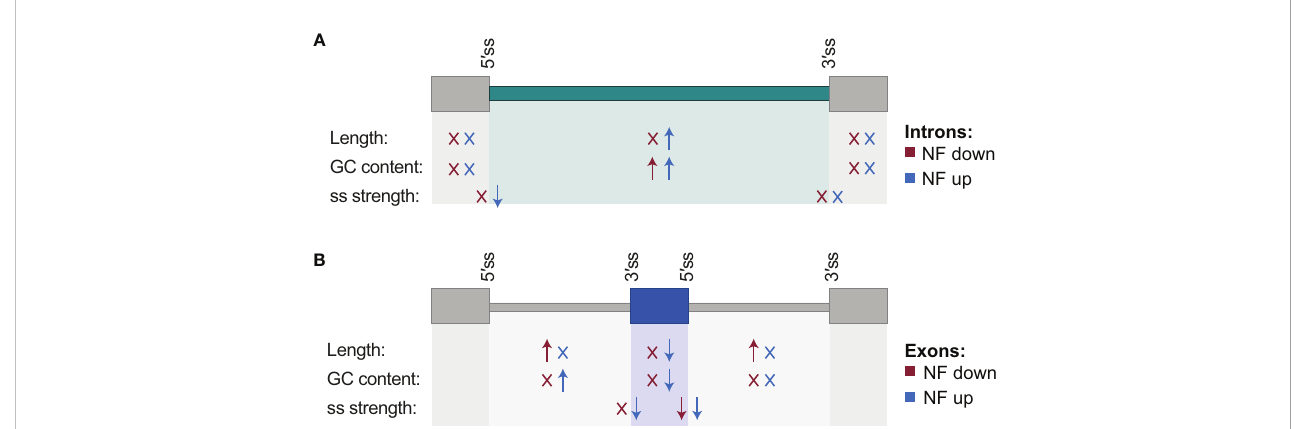
FIGURE 3 Schematic representation of genomic regulatory features associated with differentially spliced introns and exons. For introns (A) and exons (B) , arrows summarize which features show statistically signi fi cant differences with respect to their control sets of non-regulated introns and exons, and the direction of these differences (higher or lower medians; Mann-Whitney U test; P < 0.05). “ X ” indicates no statistically signi fi cant difference. Features include length of the alternatively spliced sequence together with its downstream and upstream exons/introns, GC content, and splicing site strength of their 5´ and 3´ splice sites. Differences are indicated separately for events for which the inclusion of the alternative sequence is down- (red) and up- (blue) regulated by nor fl urazon (NF). Associated values are shown in Supplemental Figure 7.